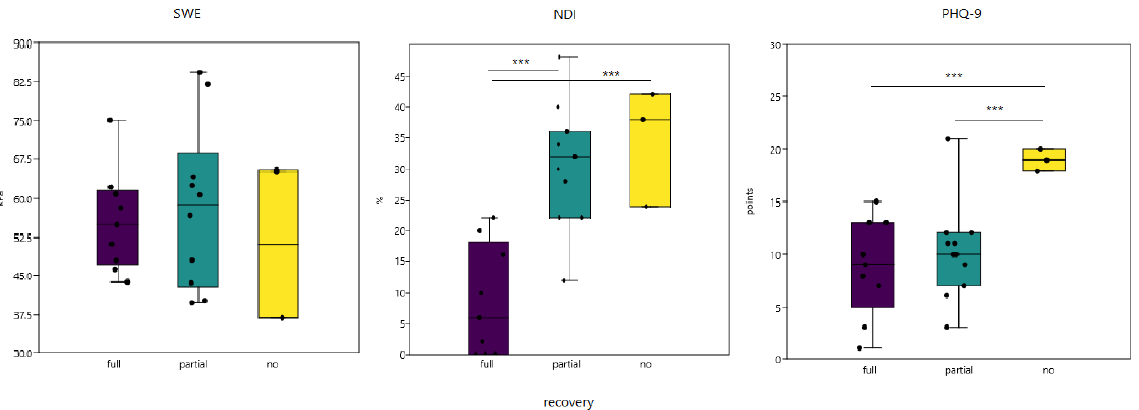
Figure 4. Differences in endpoint shear wave elastography measured as an average of both radiologists, Neck Disability index after 6 months, and initial PHQ-9 in comparison to patient perceived recovery status, *** p < 0.0001, t -test (mean ± 95% CI).